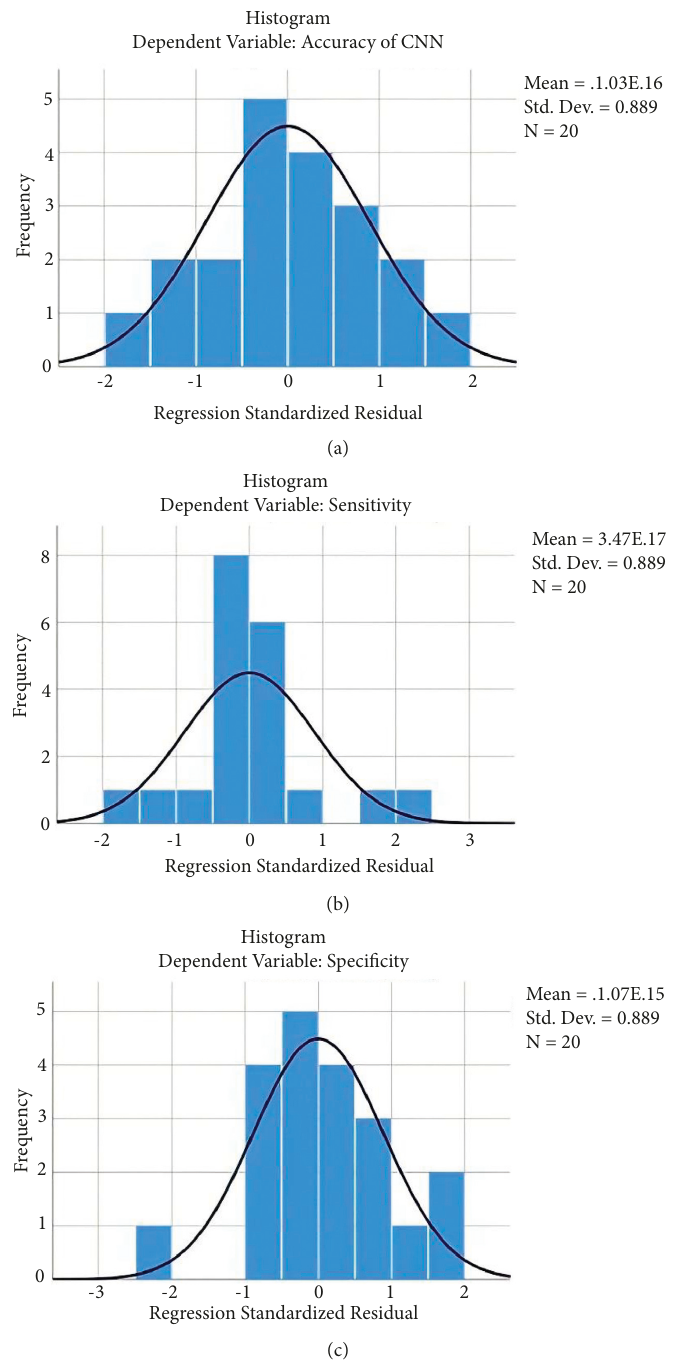
Figure 6: Histogram plot showing the skewed curve of accuracy (a), sensitivity (b), and specificity